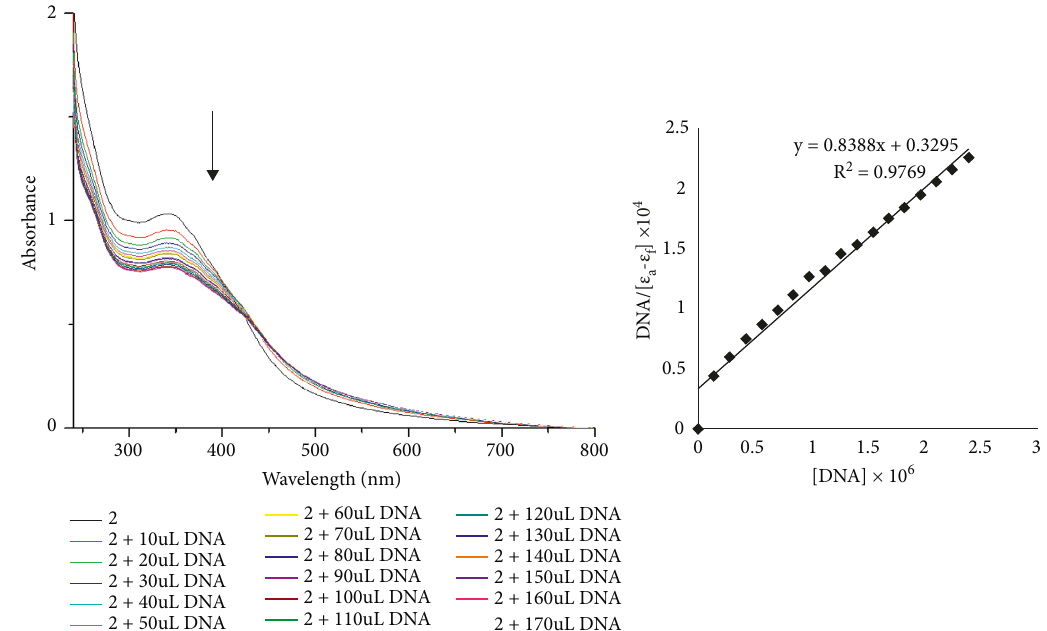
Figure 7: Electronic absorption spectrum and plot of [DNA]/ ε